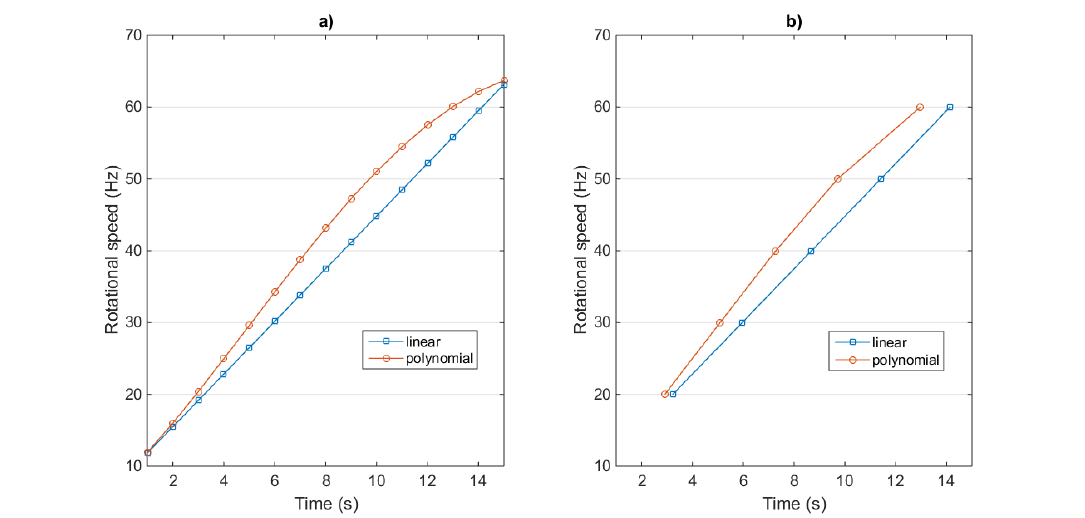
Figure 5. ( a ) The mean speed of the dataset used considering consecutive 1-s windowing; ( b ) The mean speed of the dataset used shifting 1-s windowing to get the same mean